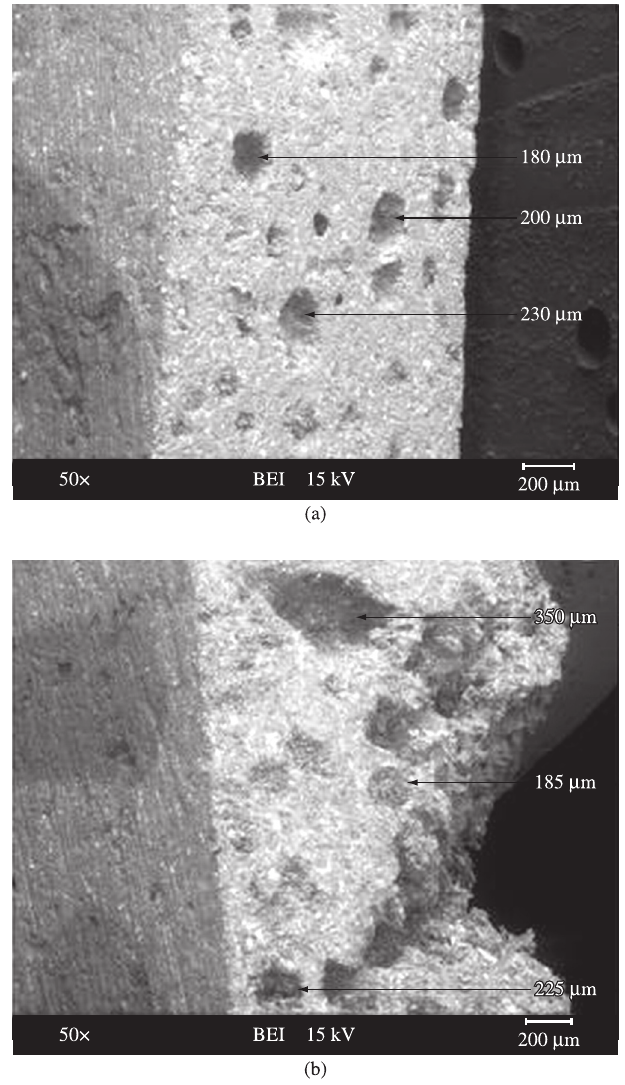
O at 2 Figure 3. SEM images of grinded fracture surfaces of specimens from COOL formulation A (top) and A/2